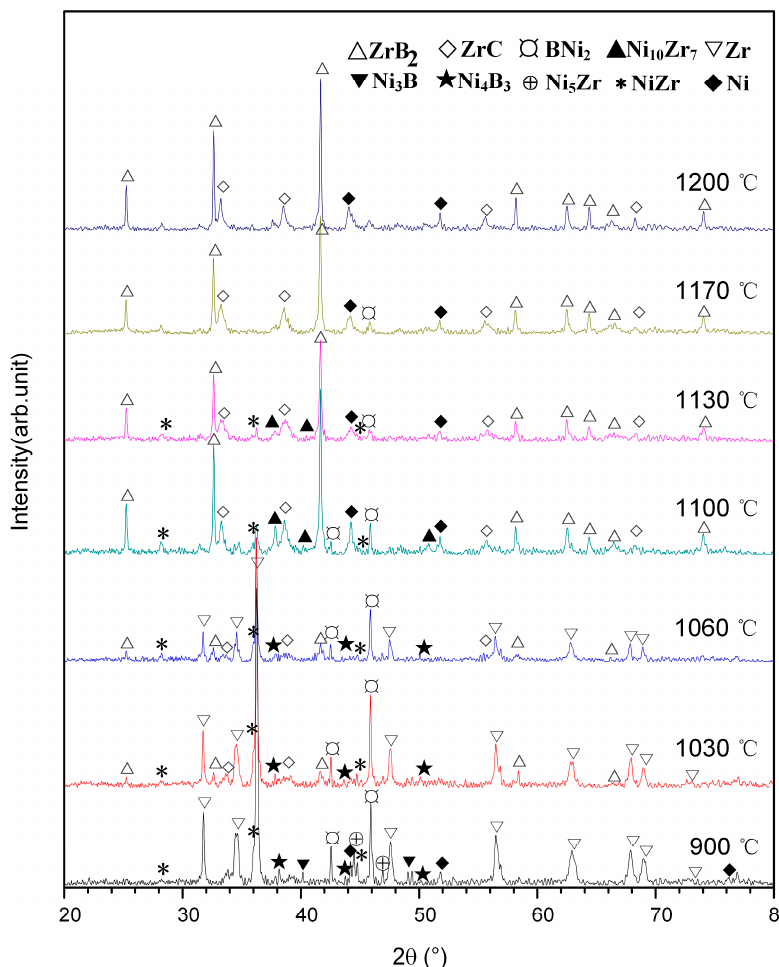
Figure 5. XRD patterns for the DSC products of 30 wt.% Ni-Zr-B 4 C mixtures quenched at different temperatures.